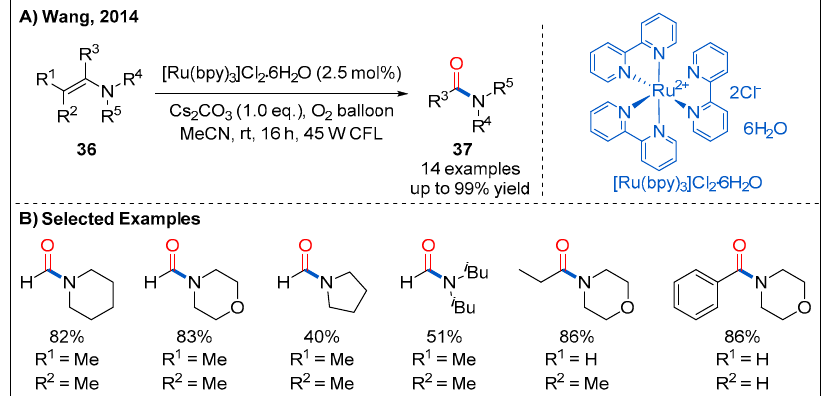
Figure 14. Photocatalytic aerobic oxidation of enamines to amides.